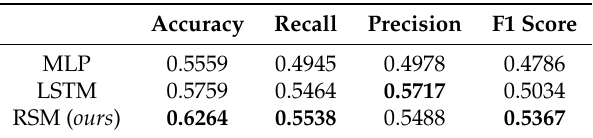
Table 2. Model evaluation scores on accuracy, recall, precision, and F1 measure. Bitcoin price in U.S. dollar (BTCUSD) from the OkCoin market was used as the dataset. We used the last 120k data points for the evaluation, which were not used in training and validation.